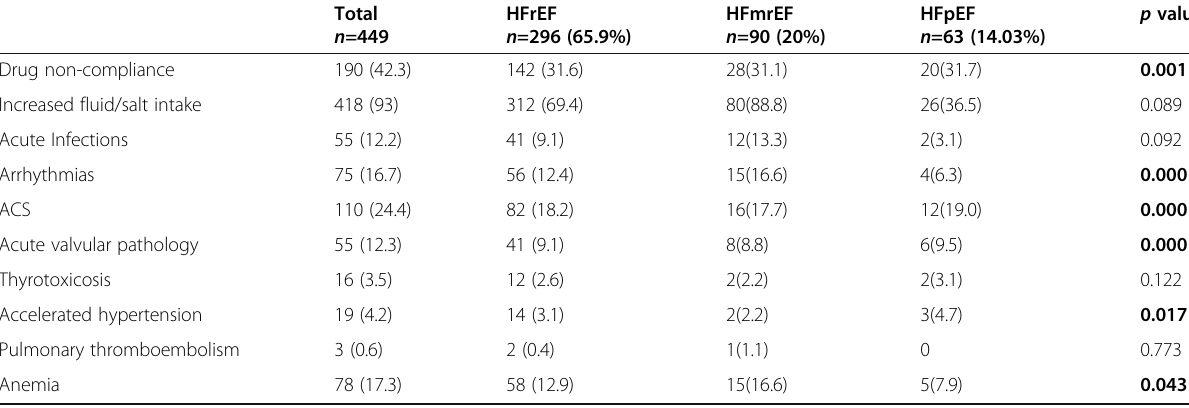
Table 2 Precipitating factors for heart